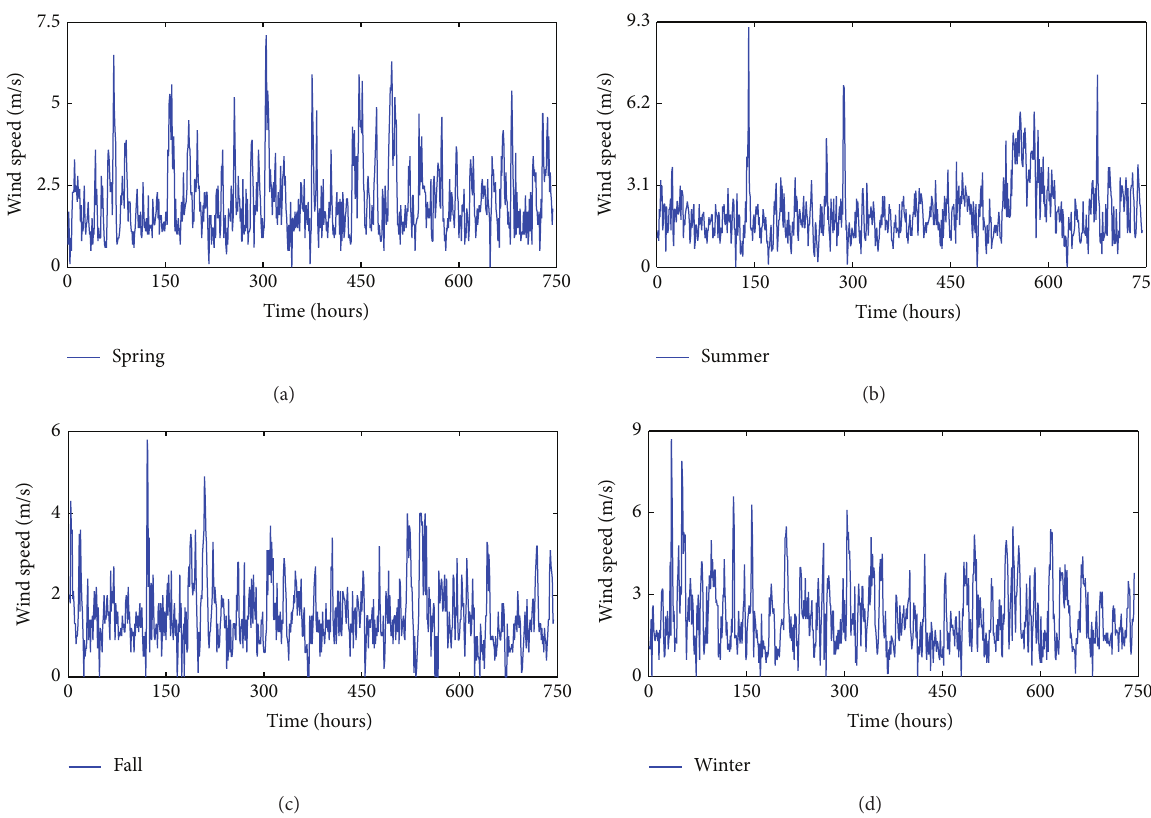
Figure 3: Original wind speed series for the four seasons: (a) spring, (b) summer, (c) fall, and (d) winter.